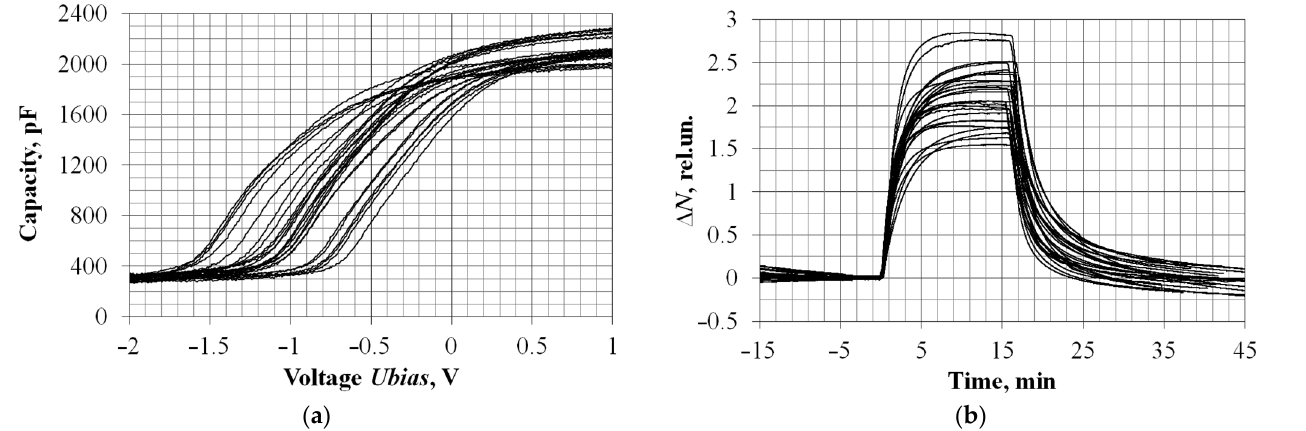
Figure 9. The test results of the operating parameters for assembled miniature capacitive sensors. ( a ) Capacitance–voltage characteristics at an operating temperature of 100 °C, measured on an AMM-3068 RLC meter with a test signal frequency of 20 kHz and an amplitude of 50 mV. ( b ) Dynamics of changes in sensor responses when a fixed hydrogen concentration of 5 ppm was supplied for 15 min (T = 120 °C). The start of the gas supply corresponds to “0” on the time axis.